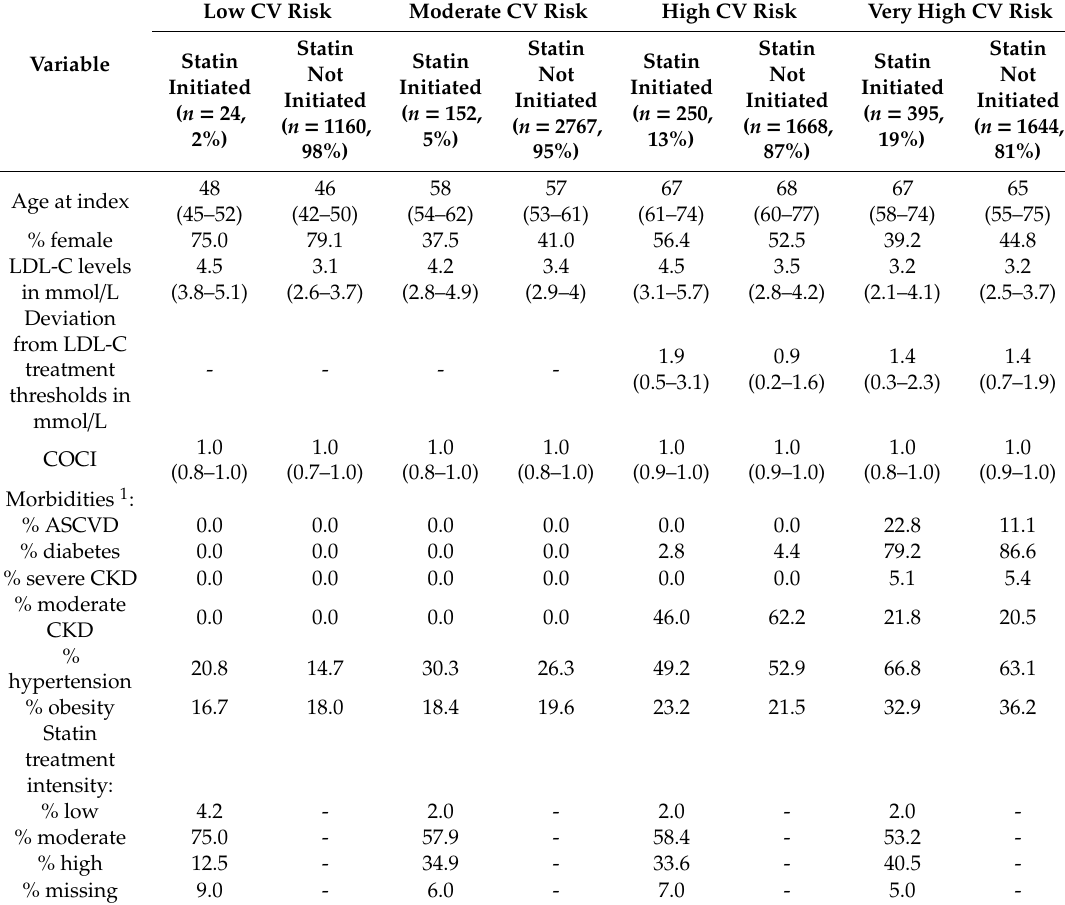
Table 1. Description of patients stratified by cardiovascular risk and statin treatment